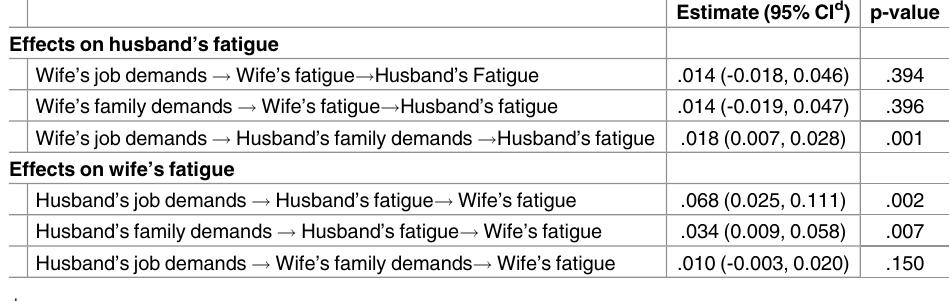
Table 3. Indirect pathways from work demands to partner’s fatigue through partner’s family demands.